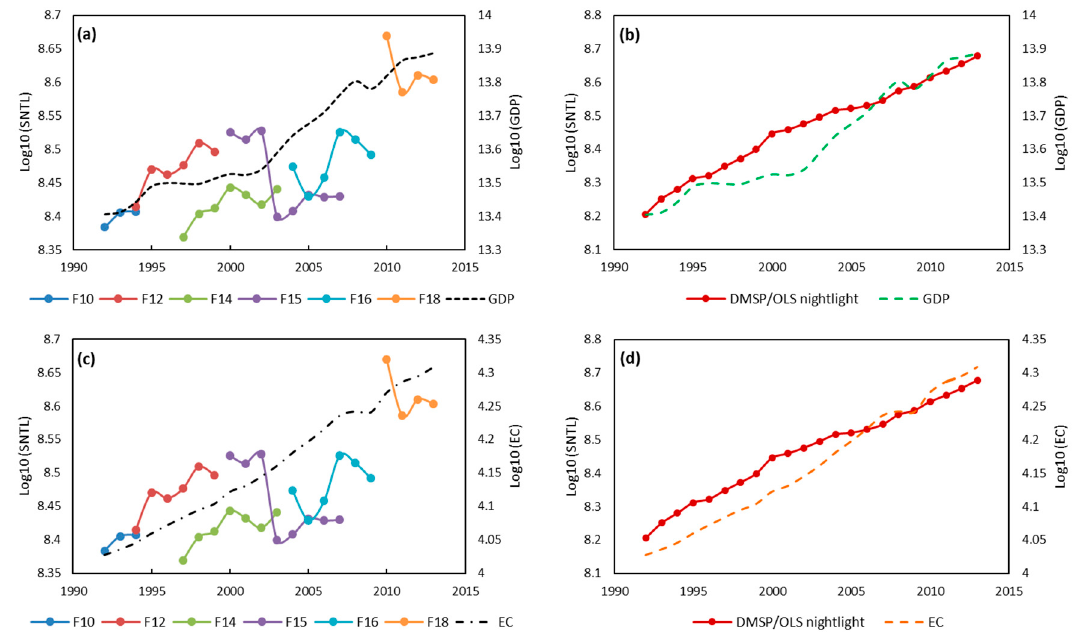
Figure 1. Gross domestic product (GDP; unit: trillions of dollars) and global the sum of NTL (SNTL) (1992–2013) from ( a ) the raw NTL and ( b ) the calibrated NTL. Electricity consumption (EC; unit: billion kWh) and global SNTL (1992–2013) from ( c ) the raw NTL and ( d ) the calibrated NTL. DMSP/OLS—Defense Meteorological Satellite Program/ Operational Linescan System.